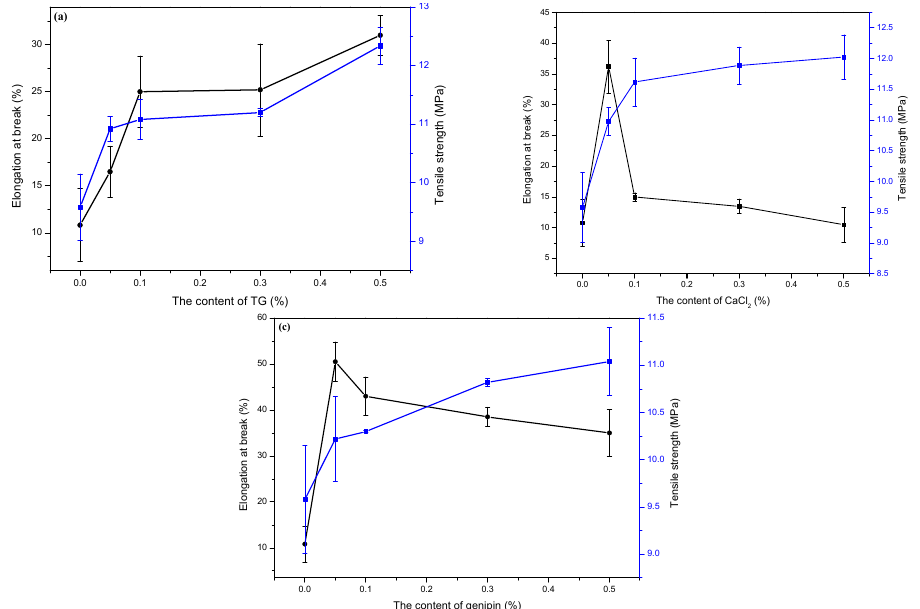
Figure 3. Tensile properties of ( a ) P-40-25 cross-linked by TG, ( b ) P-40-25 cross-linked by CaCl 2 , and ( c ) P-40-25 cross-linked by genipin.